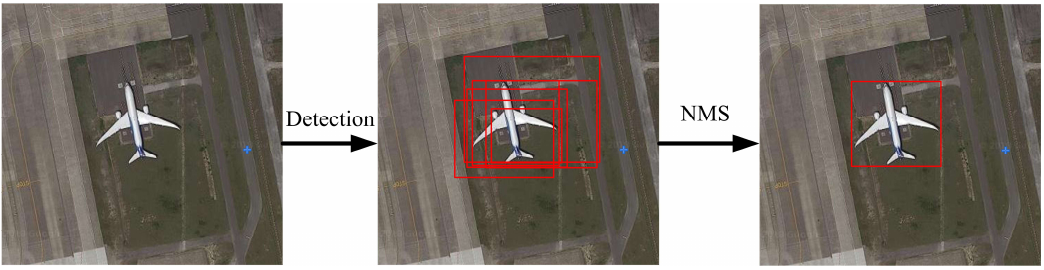
Figure 8. The nonmaximum suppression.